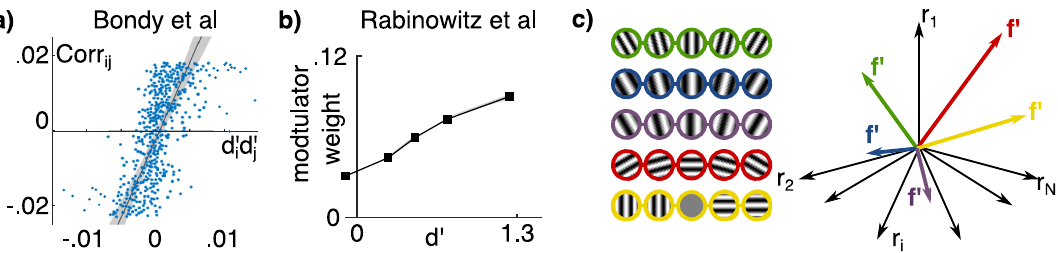
Fig 5. Examples of predicted effects in existing empirical literature. Corr denotes correlation, and d 0 is the normalized sensitivity of i neuron i defined as d 0 � f 0 = s . a) Data replotted from Fig 5c of [Bondy et al. (2018)], who isolated the task-dependent component of i i i noise correlations in macaque V1 and found a strong relation between elements of this correlation matrix and neural sensitivities and d 0 follows from the relationship between S and f 0 (r = 0.61, p < 0.001, from original paper). This relationship between Corr d 0 f 0 ij ij i j i j as in Eq (8). b) Data replotted from Fig 2d of Rabinowitz et al. (2015) [26], who found that the strength of top-down ‘modulator’ weights is linearly related to d 0 . c) Illustration of the task-dependent and arbitrary nature of f 0 : each row of grating stimuli define a different discrimination task, with each task defining a different f 0 vector in neural space. For instance, relative to fine discrimination around vertical (green), one may modify the spatial frequency (blue), the phase (purple), the reference orientation to horizontal (red), or consider a coarse discrimination between vertical and horizontal (yellow). The span of possible f 0 directions is large. Hence, the probability is small of finding that the specific f 0 direction corresponding to a given task is aligned with a leading principal component of measured noise covariance, unless this alignment is the result of learning and/or performing the